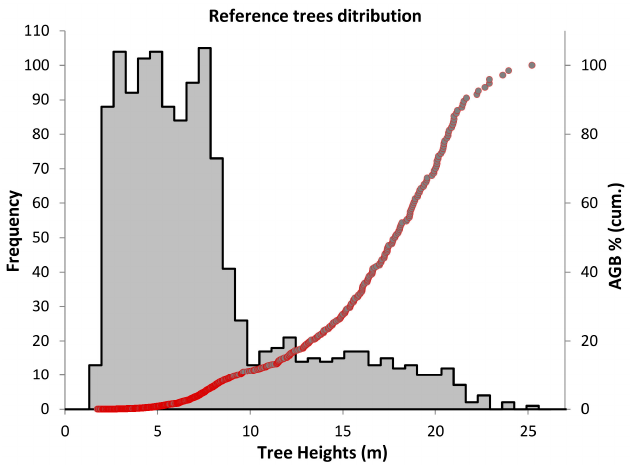
Figure 1. The height class and cumulative aboveground biomass (AGB) (red line) distribution of reference trees ( n = 1277) in the 2.2 ha study area.